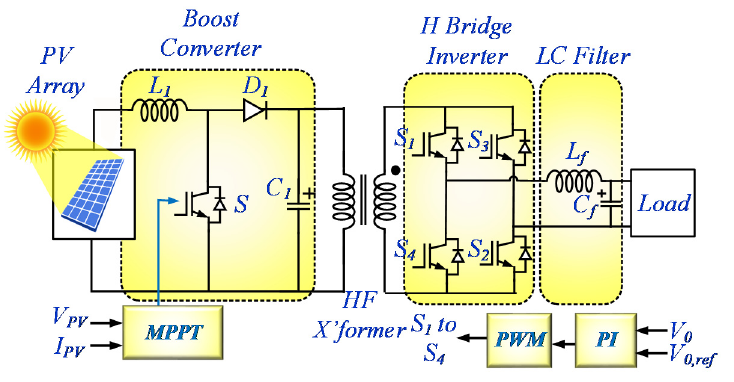
Figure 5. Micro-inverter.